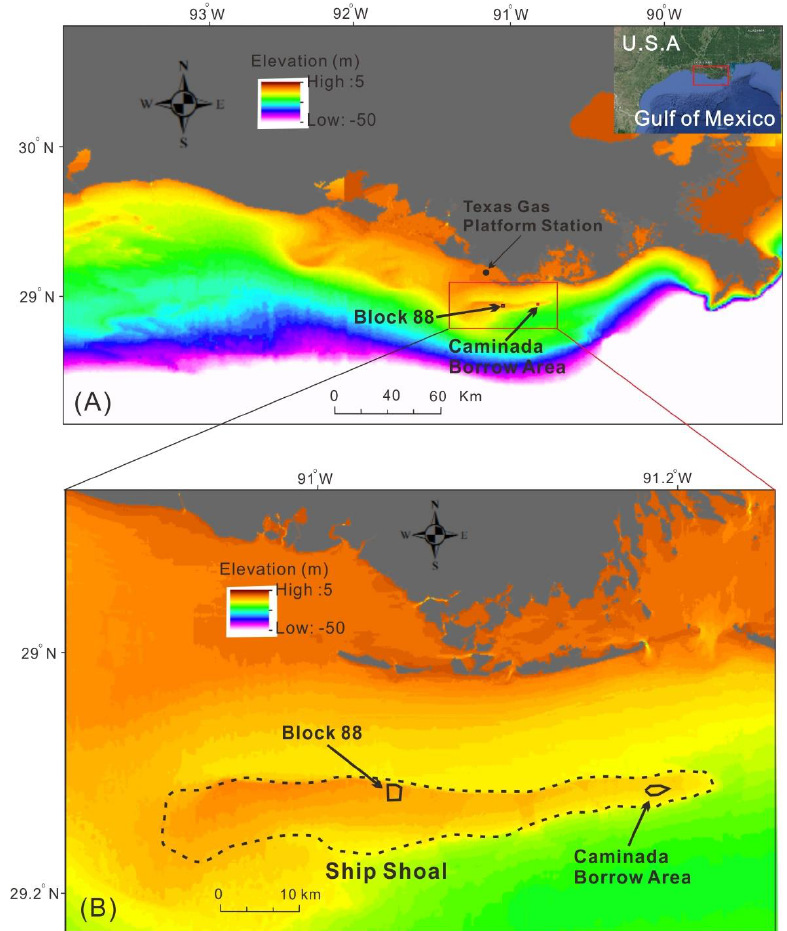
Figure 1. ( A ) A map showing the location of two sandy pits along the Louisiana shelf. The Texas gas platform station is the NOAA (National Oceanic and Atmospheric Administration) tide and current station (ID: 8763535) for tide and bathymetry correction. ( B ) Two borrow areas in Ship Shoal are Block 88 and Caminada. This study focuses on the Caminada dredge pit.